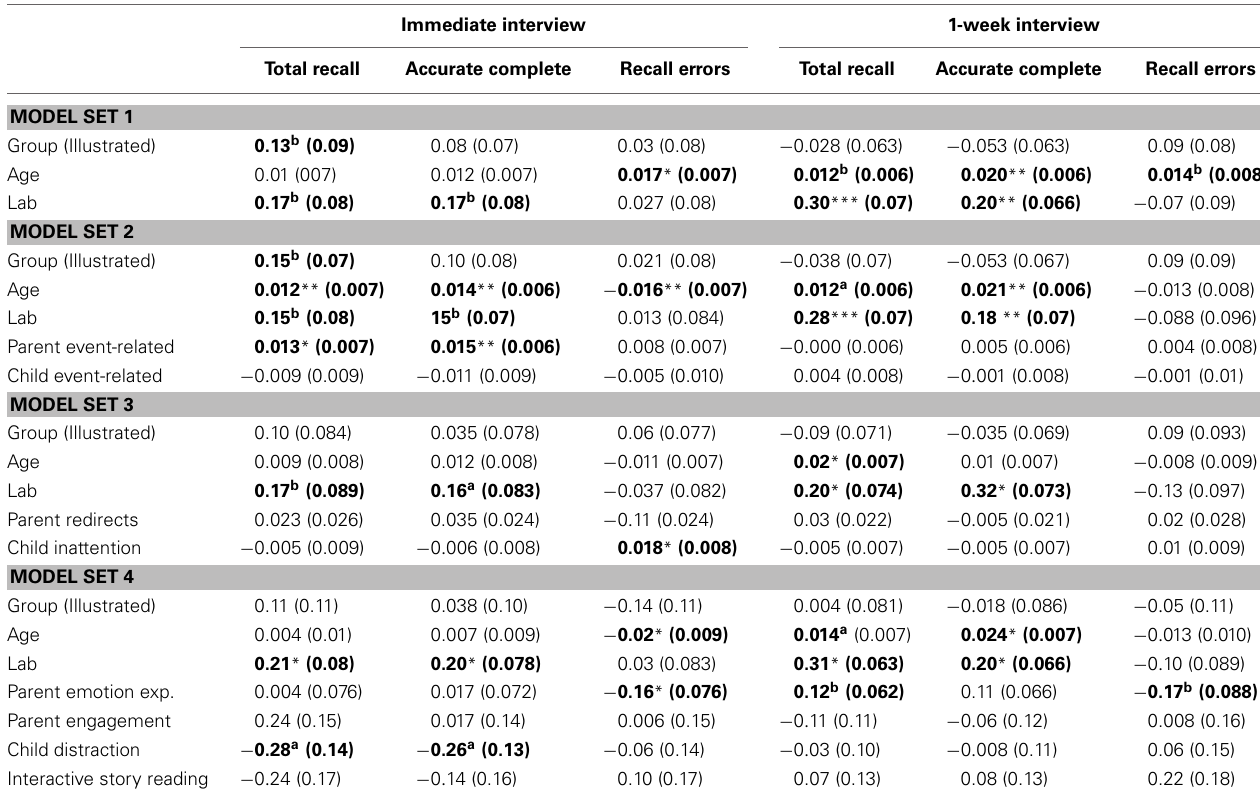
Table 3 | Parameter estimates (and standard errors) generated by GLMs predicting recall performance from child age, experiment location, group, and parent-child story reading